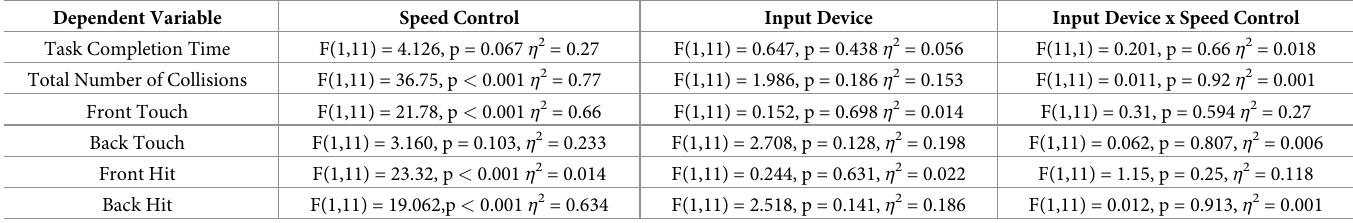
Table 1. Fisher’s test results for study 1.